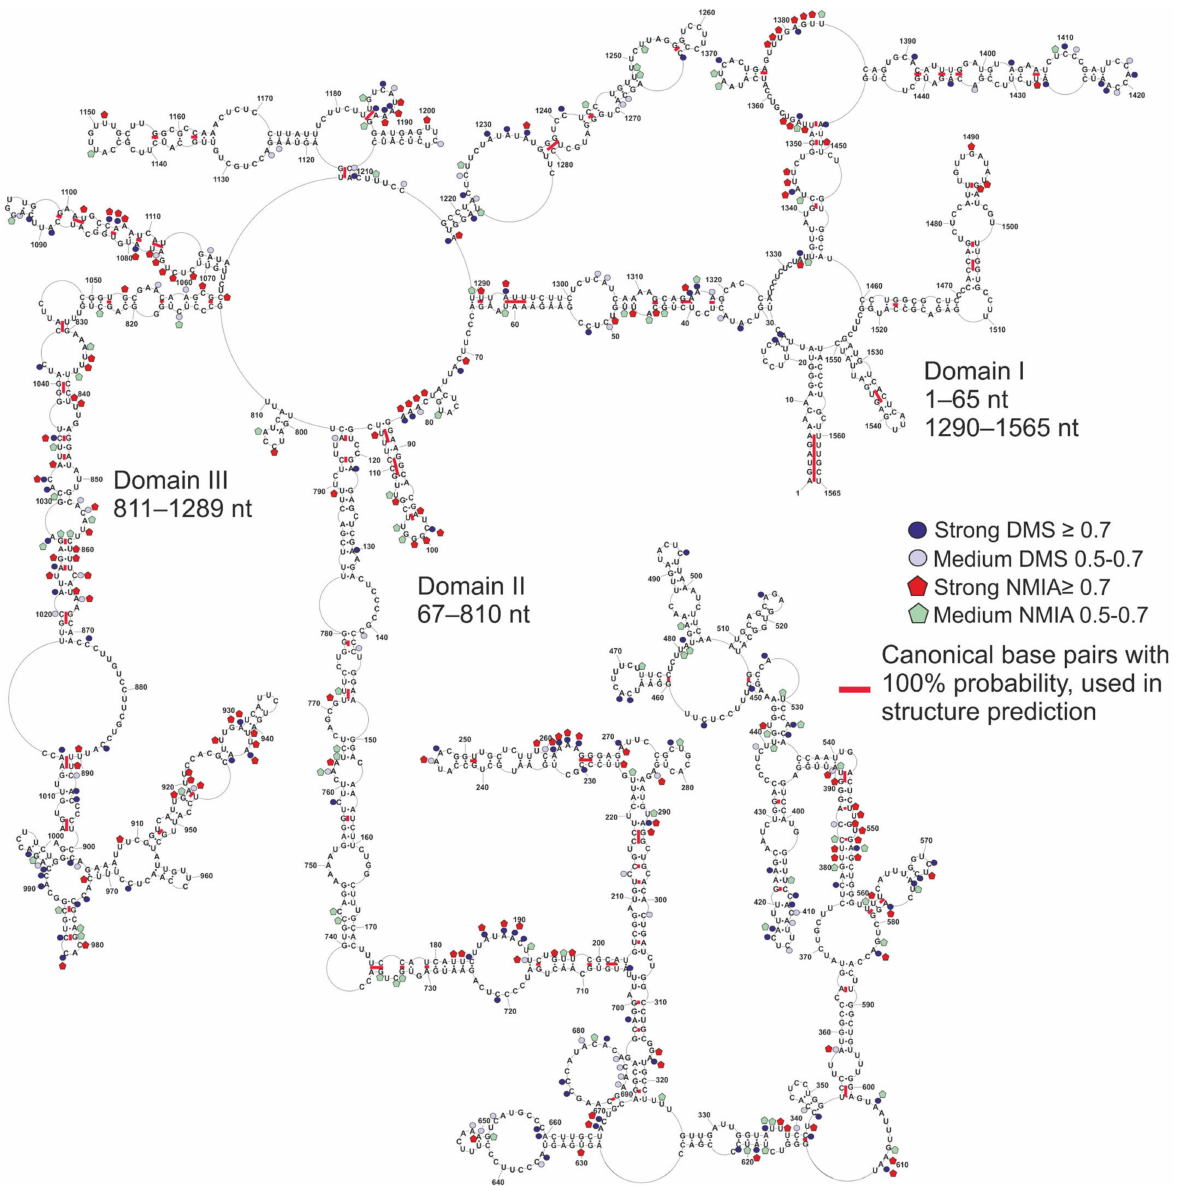
Figure 2. The secondary structure of vRNA5 A/California/04/2009 predicted using experimental data. Strong modifications of DMS and NMIA were marked on the structure. The canonical base-pairs with 100% of probability used in structure prediction are marked with